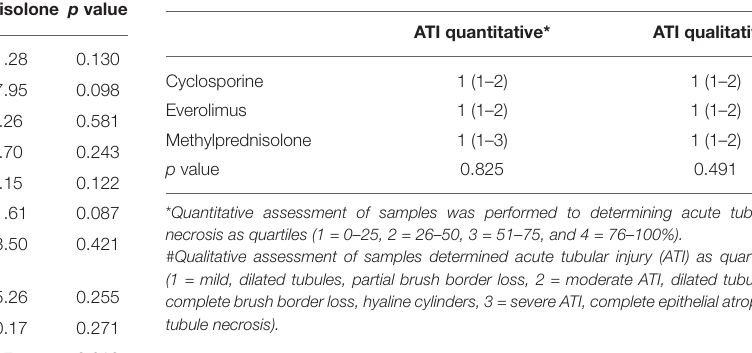
TABLE 3 | Quantitative and qualitative histopathological assessment of acute tubular injury.